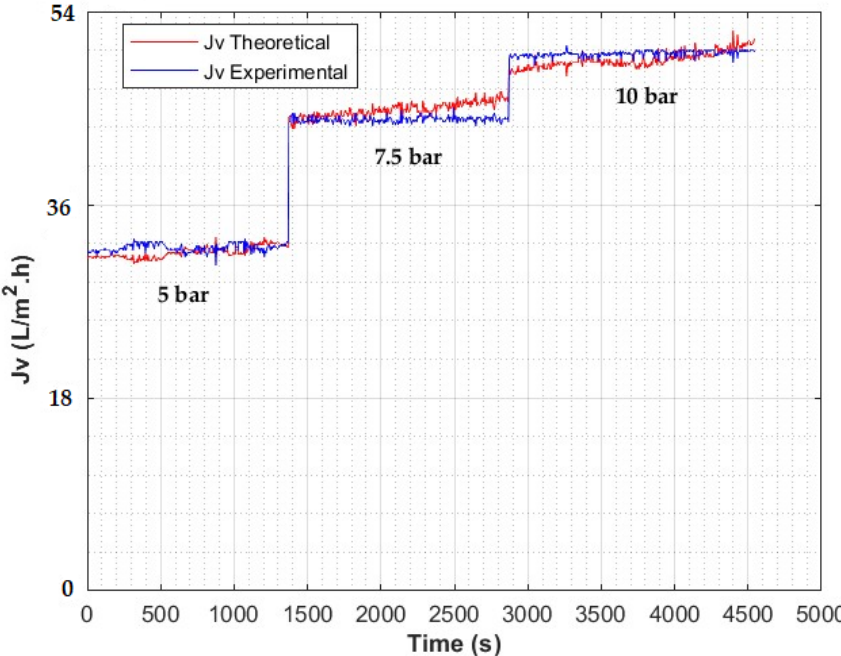
Figure 15. Theoretical vs. experimental flux of As: medium concentration.